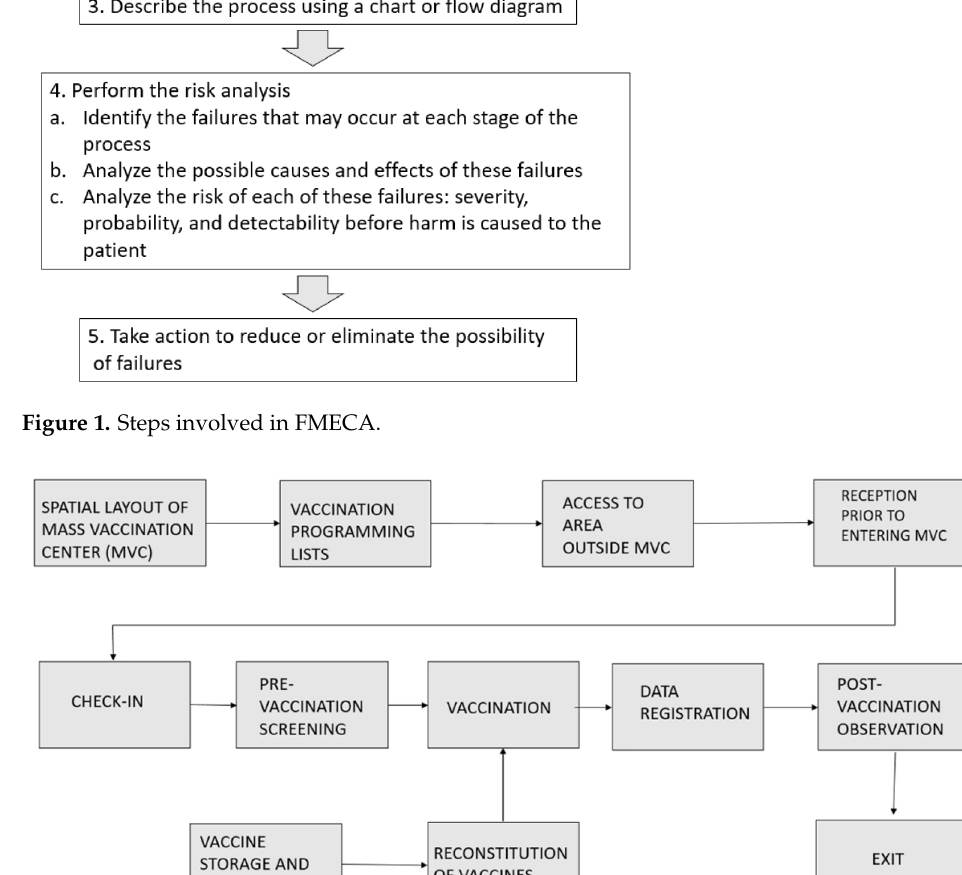
Figure 1. Steps involved in FMECA.